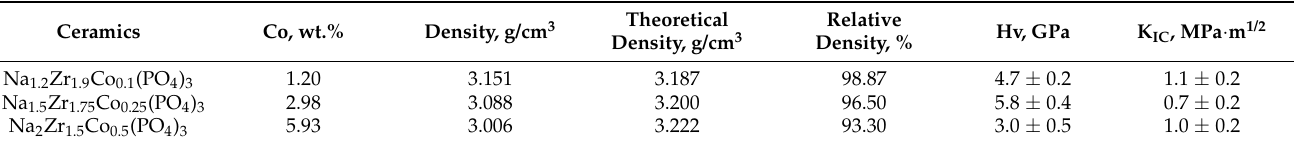
Table 2. Characteristics of Na 1+2x Zr 2 − x Co x (PO 4 ) 3